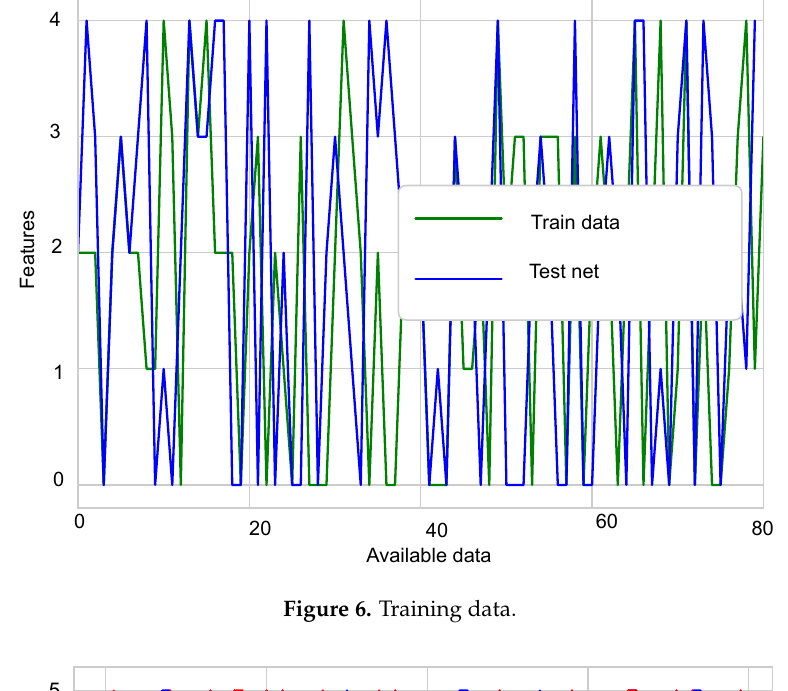
Figure 6. Training data.